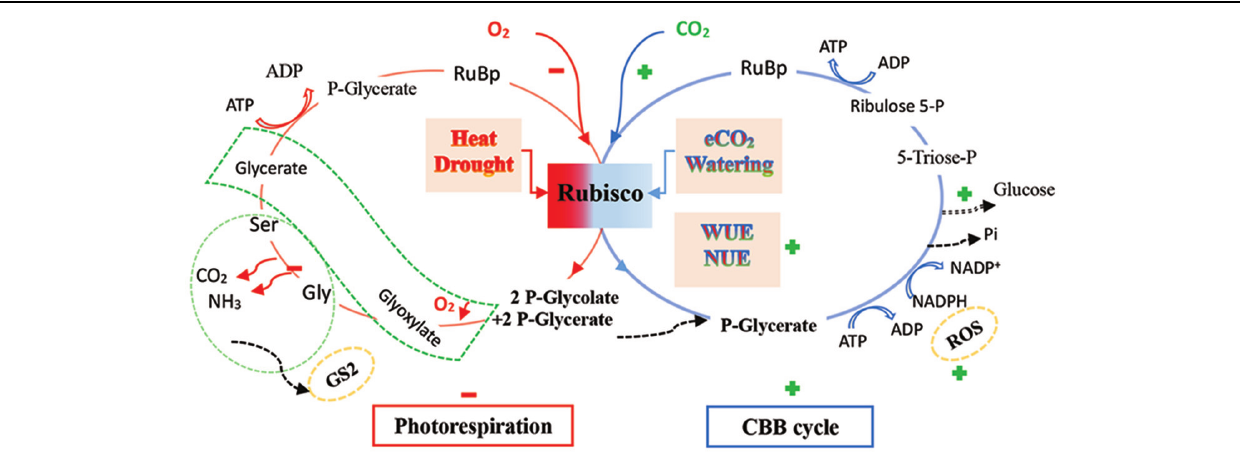
FIGURE 1 | A diagrammatic outline of the Calvin–Benson–Basshan (CBB) cycle and photorespiration pathway in plants in response to elevated CO 2 with abiotic factors. Rubisco has two sites of carboxylation and oxygenation. Elevated CO 2 (eCO 2 ) may promote carboxylation, but repress oxygenation under ample environmental conditions, such as well-watering, whereas extreme abiotic stress, such as heat and drought, may repress carboxylation but promote oxygenation (Wingler et al., 1999; Tingey et al., 2003). An energy consumption trade-off between the key cycles may occur, possibly modified by the CO 2 level, in which photorespiration may be promoted to quench reactive oxygen species (ROS), related to glutamine synthetase (GS2) to recycle ammonia, diminishing photo-oxidation and photo-inhibition (dotted orange line ellipse; Kozaki and Takeba, 1996; Watanabe et al., 2014). A low Gly:Ser ratio provides evidence that photorespiration is repressed in eCO 2 (Kebeish et al., 2007). Water use efficiency (WUE) and nitrogen use efficiency (NUE), despite the N dilution, should be enhanced by elevated CO 2 , by decreasing stomatal conductance and investing relatively more N into the Rubisco protein (Palmroth et al., 2013). The photorespiration process is compartmentalized into the chloroplast (red line ellipse), peroxisome (dotted green line bent rectangle), and mitochondrion (dotted green line ellipse). The green plus and red minus signs denote the stimulation and suppression via rising CO 2 , respectively (mainly referring to Kozaki and Takeba,